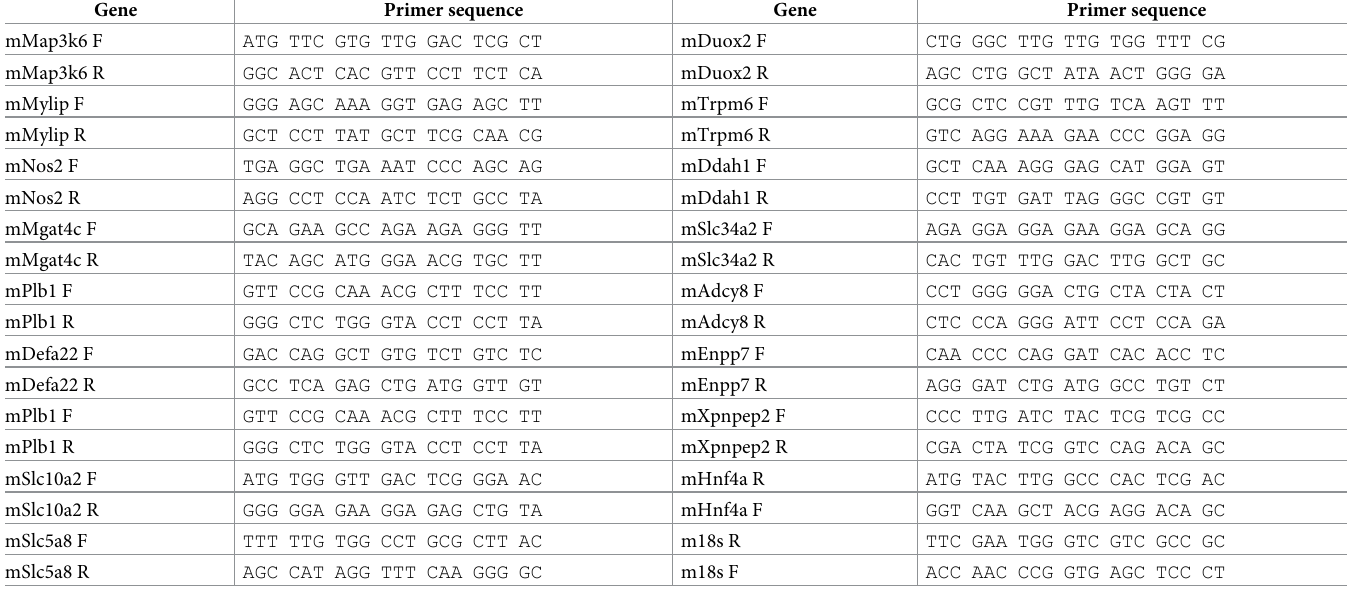
Table 1. RT-PCR primer sequences (m- mouse, F- forward primer, R- reverse primer). Gene Primer sequence Gene Primer sequence mMap3k6